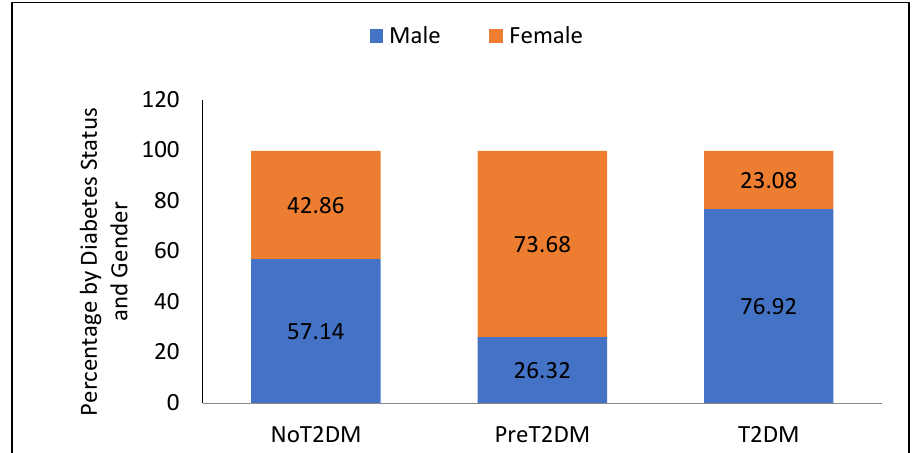
Figure 1. Participants by diabetes status and gender (T2DM = Type 2 Diabetes Mellitus).